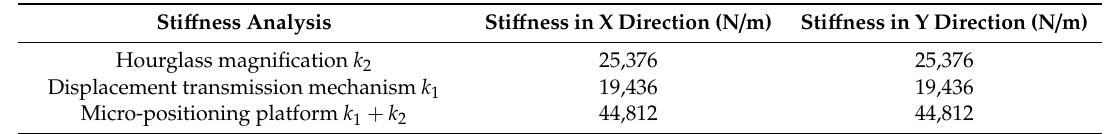
Table 1. Micro-positioning platform theoretical sti ff ness